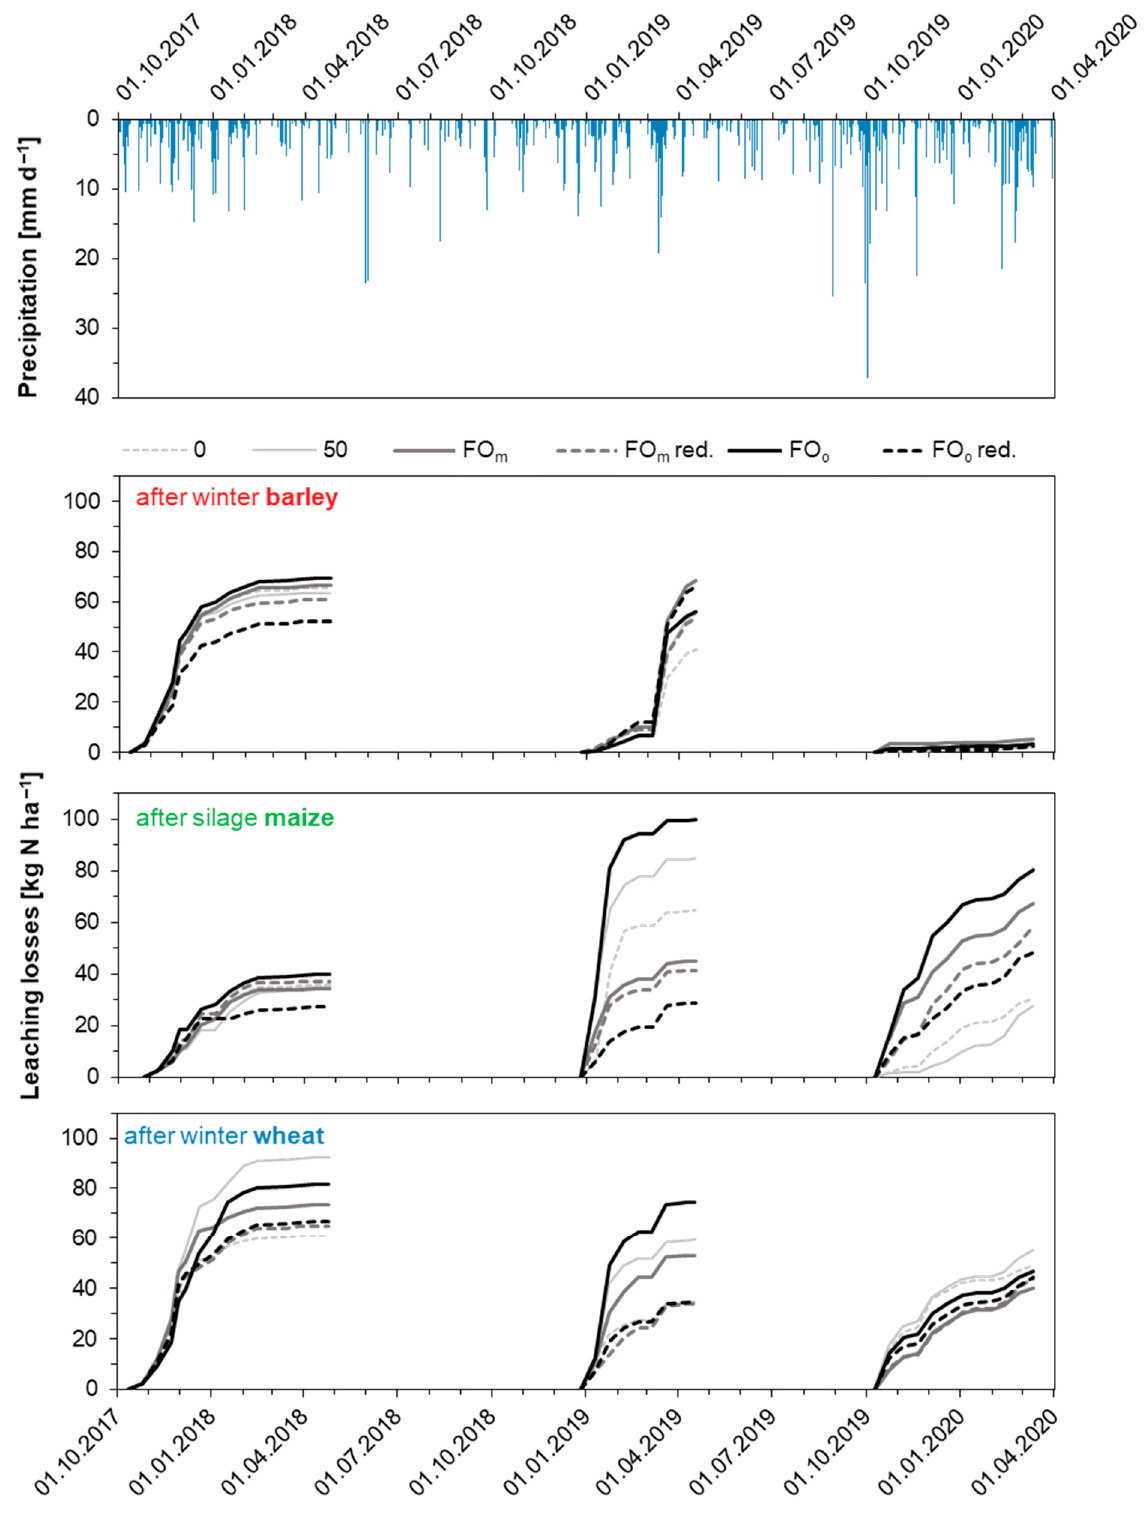
Figure 5. Cumulative leaching losses over time for all fertiliser treatments (FO: fertiliser ordinance, red: reduced, m: only mineral, o: organic + mineral).